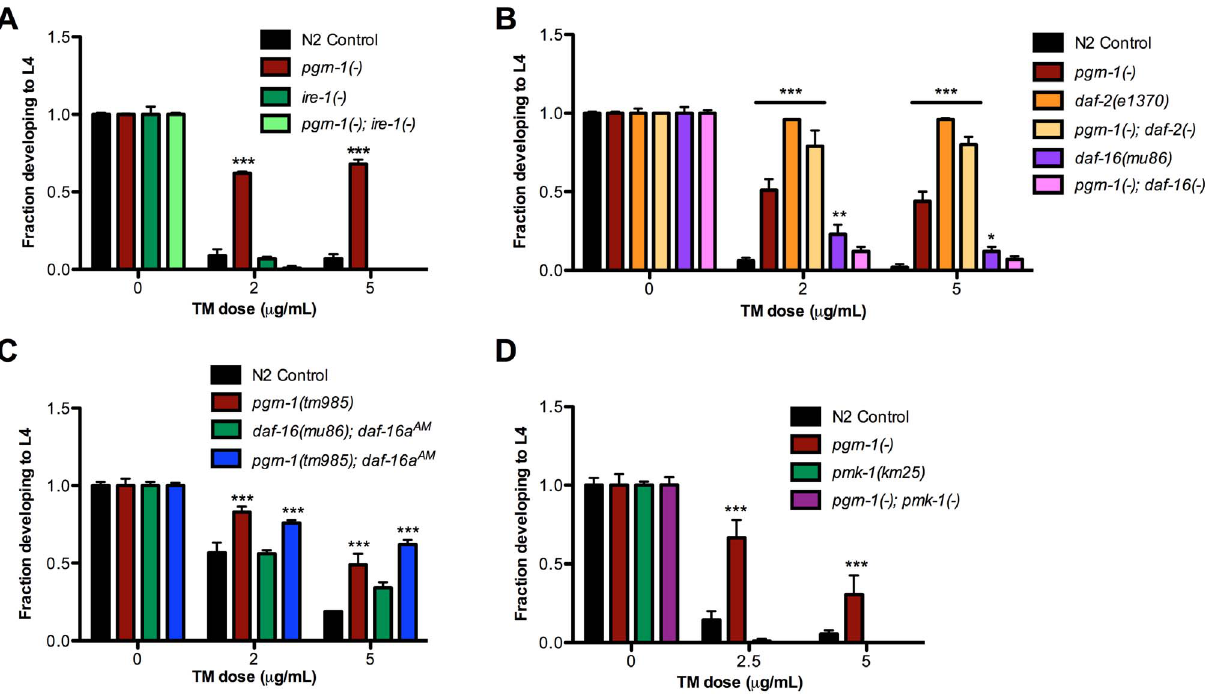
Figure 4. pgrn-1(-) resistance to ER stress may be partially dependent on the UPR pathway, daf-16 and pmk-1 . (A) Embryos from the indicated strains were grown on plates with tunicamycin (TM) and assessed for their ability to develop to the L4 stage. (B) daf-2(e1370) and daf- 16(mu86) were tested for ER stress resistance with and without pgrn-1(-) in the background. (C) daf-16(mu86); muIs113 and pgrn-1(tm985); muIs113 animals were tested for ER stress resistance. (D) pmk-1(km25) and pgrn-1(-); pmk-1(-) mutants were tested for ER stress resistance. Error bars represent standard deviation. Statistical comparisons are to N2 control (Two-way ANOVA with Bonferroni post-tests). *p , 0.05, **p , 0.01, ***p , 0.001. For additional statistical data, see Table